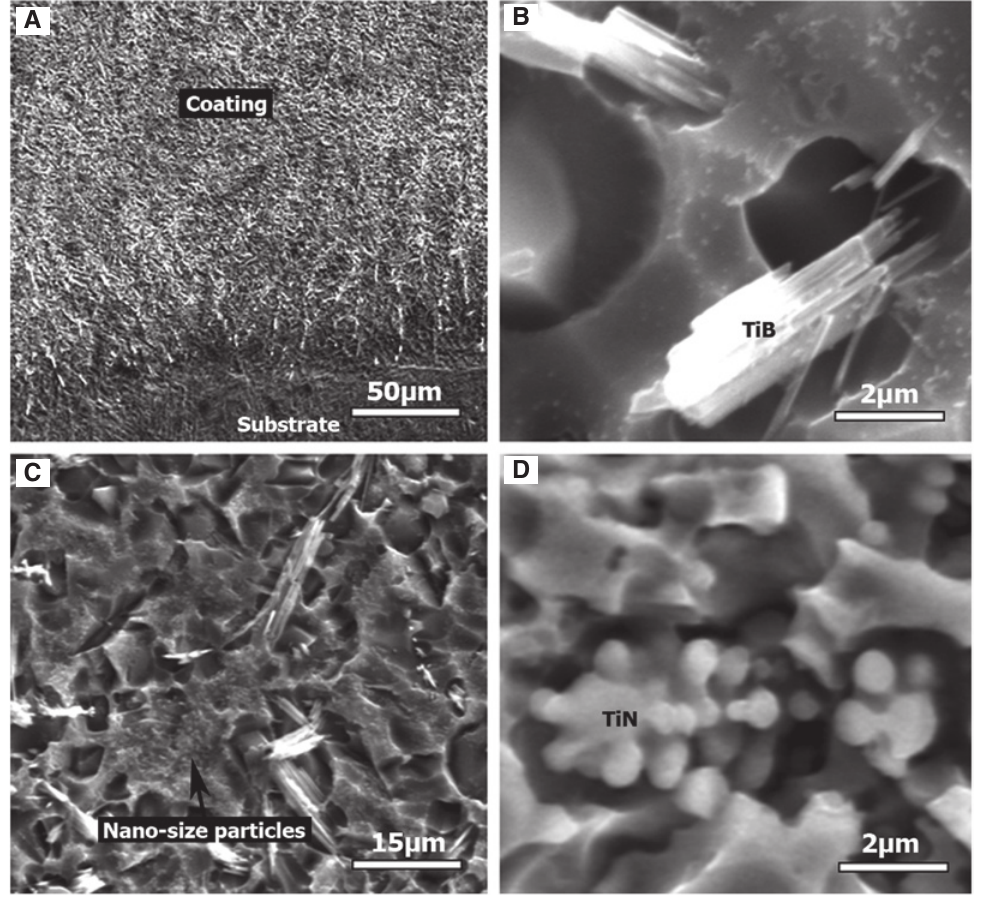
Figure 1 SEM micrographs of the composite coating: (A) bonding zone, (B) the borides, (C) nano-size particles, and (D) the fine TiN